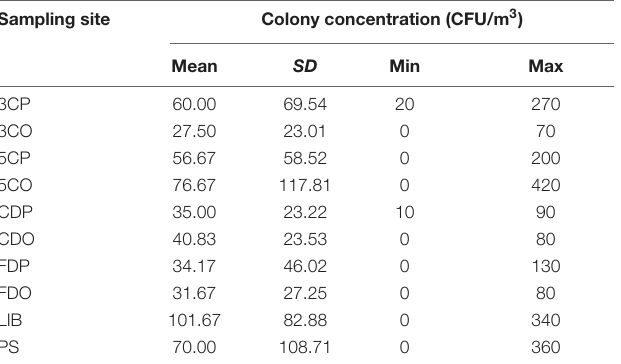
( Figure 3 ). Looking at the effect of human presence and